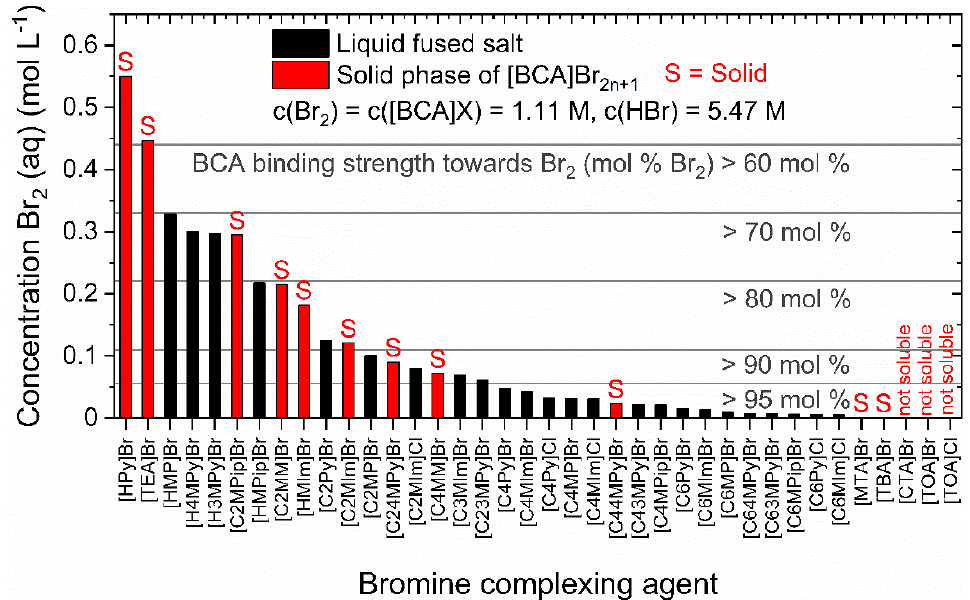
Figure 2. Concentrations of Br 2 in the aqueous electrolyte phase and aggregate state of the fused salt (black bars = liquid, red bars = solid) of all BCAs shown in Table 1 for a selected state of charge (SoC) of 33% at θ = 23 ± 1 °C. The sorting is carried out for increasing bromine binding strengths (BCA complexation strength) of the fused salt. Non-soluble BCAs are shown on the right side. The binding strength (text in grey color) of the BCA indicates the fraction of Br 2 related to 1.11 M Br 2 bound in the fused salt at an SoC of 33%.